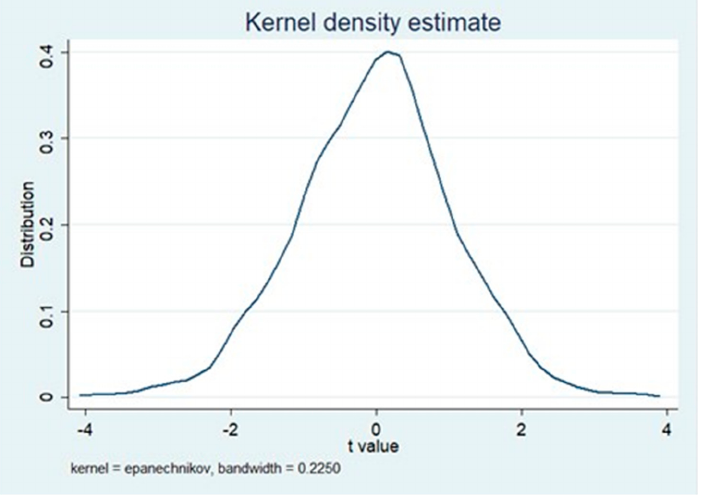
Figure 1. Placebo test